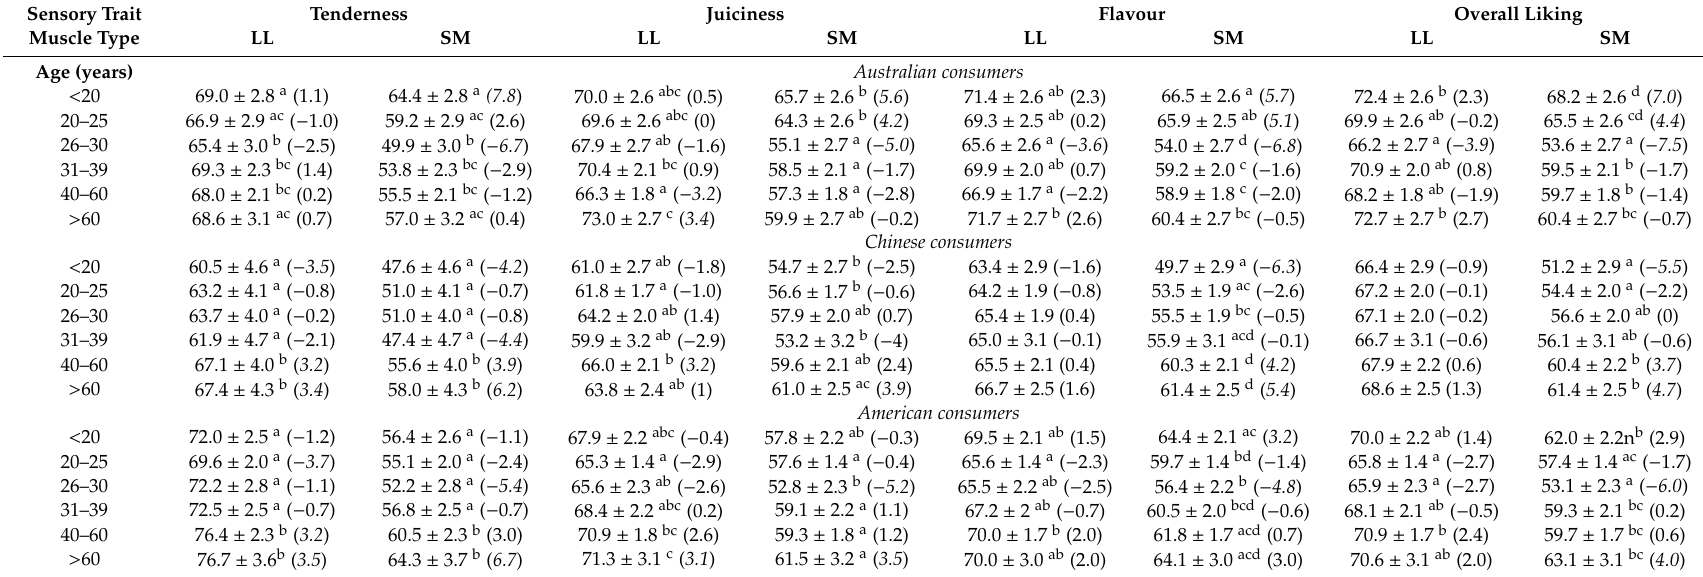
Table 3. Least square means ± standard error (on a scale of 0–100) of tenderness, juiciness, flavour and overall liking scores of m. longissimus lumborum (LL) and m. semimembranosus (SM) samples by a consumer’s country and age group. Values within brackets signify di ff erence from mean of country and muscle type ( italics = greater than 3 units from the mean